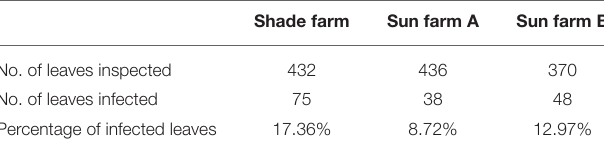
TABLE 4 | Comparison of Roya fungus presence.